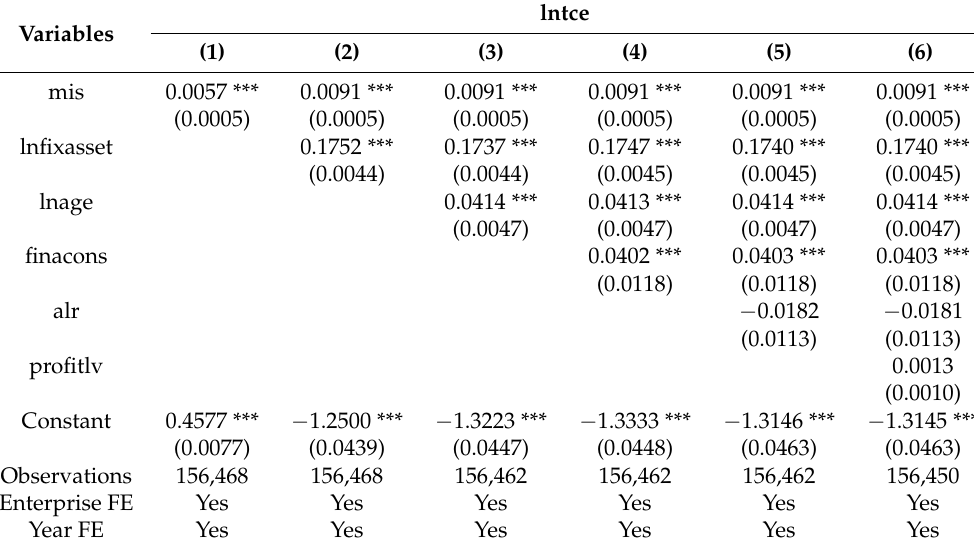
Table 4. Empirical results of Hypothesis